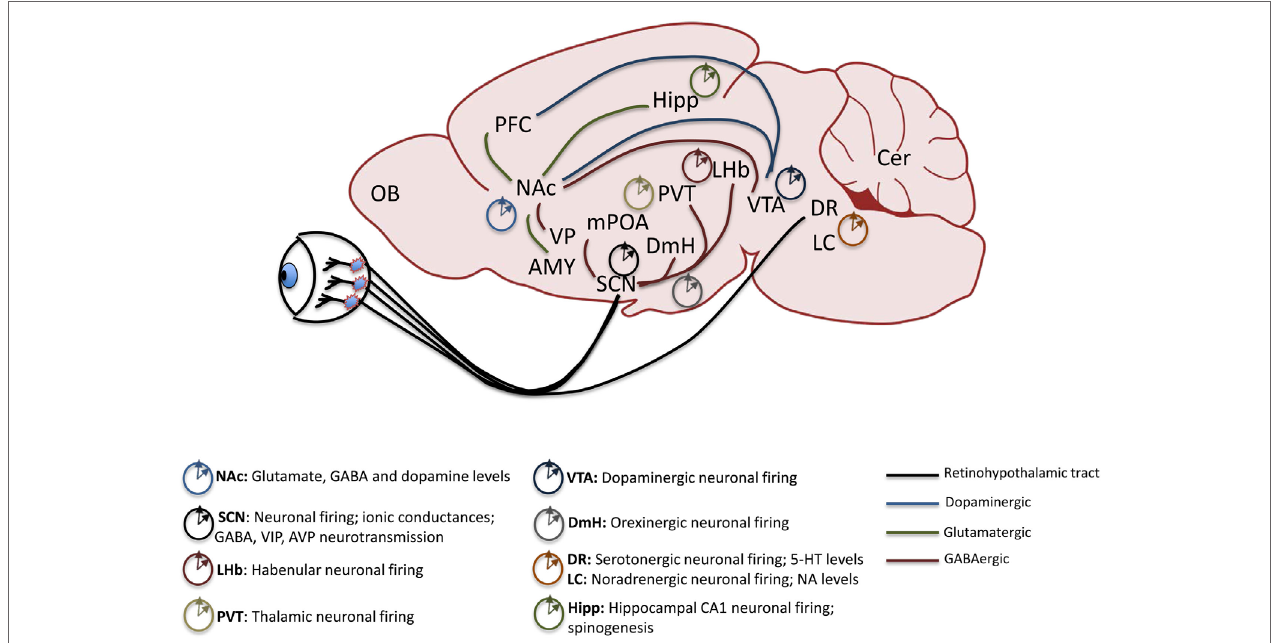
FiGURe 1 | Mesolimbic brain regions display rhythmic patterns in neural activity. The retinohypothalamic tract provides light information and consists of ipRGC projections from the retina to the SCN and DR. The SCN provides direct GABAergic input to the LHb, DmH, mPOA, and the PVT. Reward-related pathways include a dopaminergic projection from the VTA to the NAc and PFC, glutamatergic inputs from the Hipp, Amy and PFC to the NAc and GABAergic output of the NAc to the VP and VTA. Known rhythmic components of neural activity in each of the mood and reward-related extra-SCN brain regions are denoted. ipRGC, intrinsically photosensitive retinal ganglion cells; SCN, suprachiasmatic nucleus; DR, dorsal raphe nuclei; LHb, lateral habenula; DmH, dorsomedial hypothalamus; mPOA, medial pre-optic area; PVT, paraventricular thalamic nucleus; VTA, ventral tegmental area; NAc, nucleus accumbens; PFC, prefrontal cortex; Hipp, hippocampus; Amy, amygdala; VP, ventral pallidum; LC, locus coeruleus; OB, olfactory